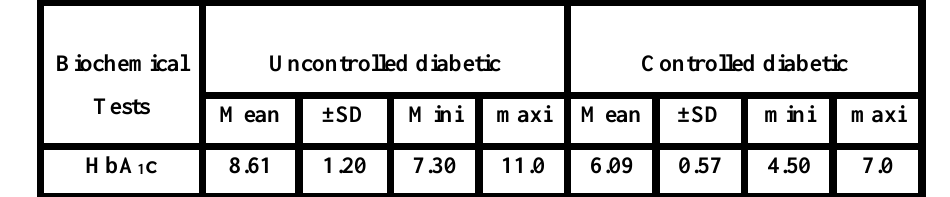
c and salivary glucose among uncontrolled and 1